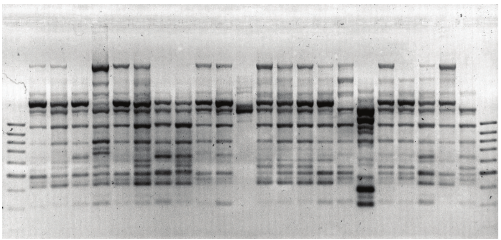
Figure 4: Amplified PCR product using OPC-15 primer.